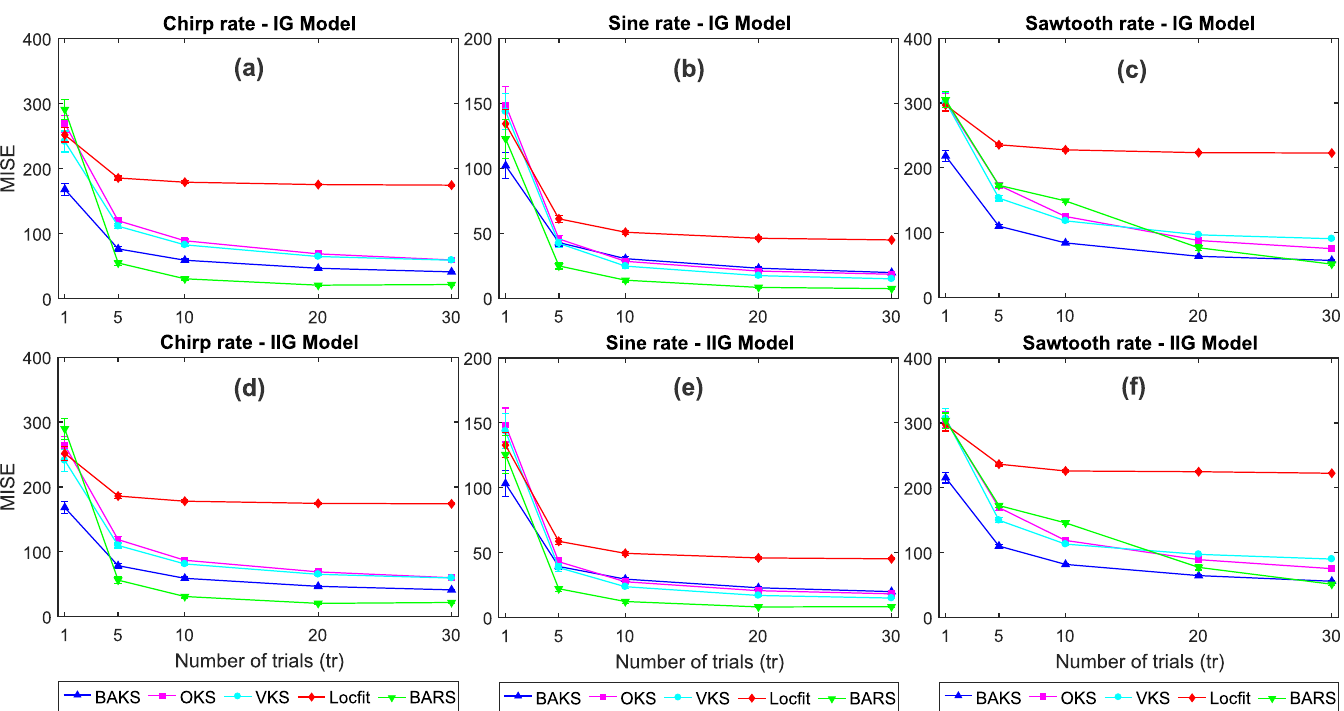
Fig 8. MISE comparison under different numbers of trials. (a)-(c) MISE comparison for chirp, sine and sawtooth rate functions, respectively, for IG model. (d)-(f) MISE comparison for chirp, sine and sawtooth rate functions, respectively, for IG model. Vertical bars (not clearly seen for tr � 5) represent the 95% confidence intervals.